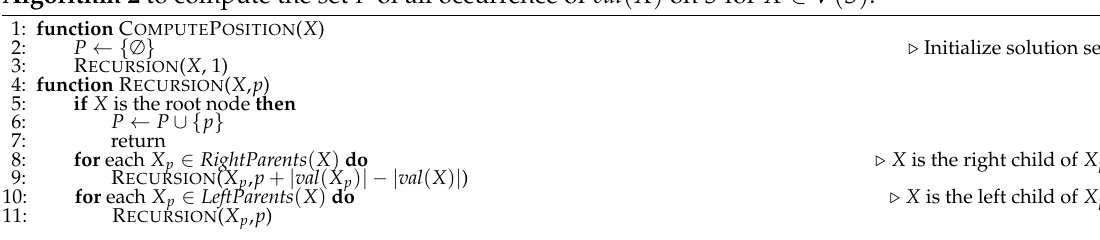
Algorithm 2 to compute the set P of all occurrence of val ( X ) on S for X ∈ V ( S ) .